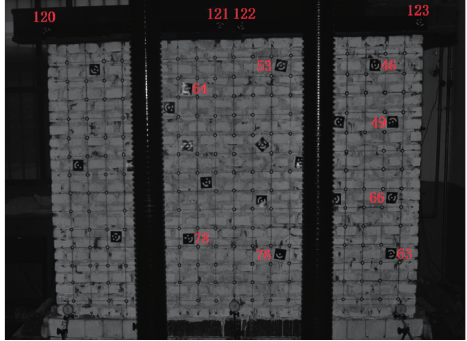
Figure 13: The layout scheme for point position precision evaluation of the photogrammetry system. Table 2: Distance mean square error of the photogrammetry system